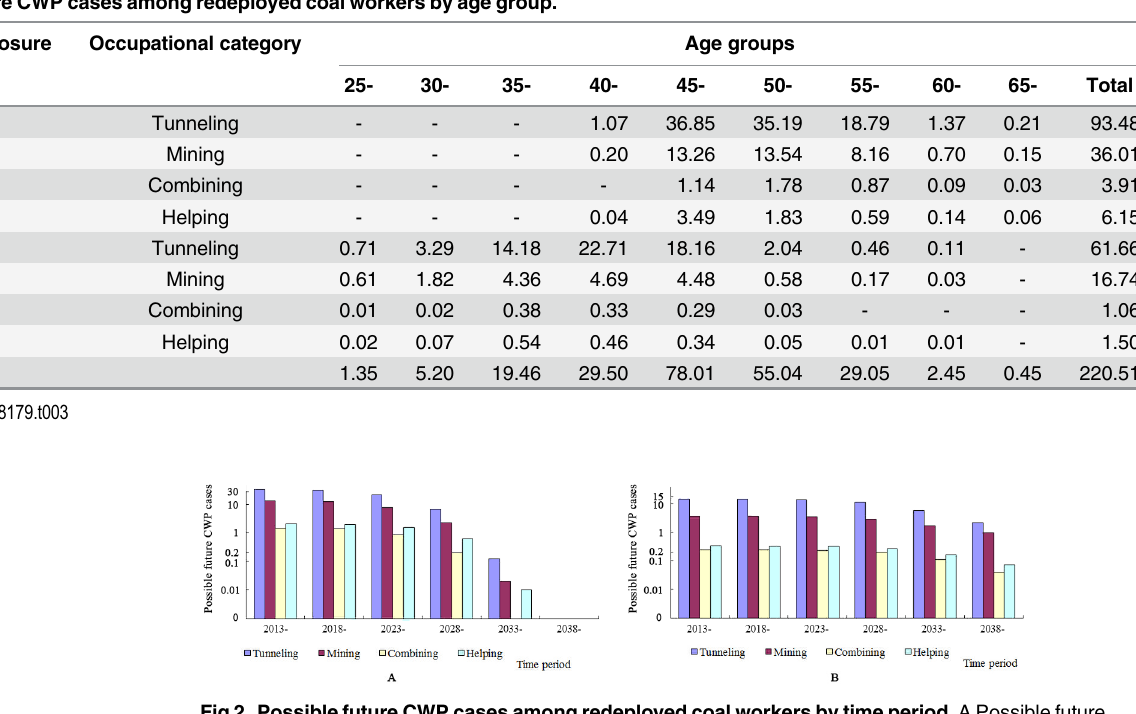
Fig 2. Possible future CWP cases among redeployed coal workers by time period. A Possible future CWP cases among redeployed coal workers of 1965-; B Possible future CWP cases among redeployed coal workers of